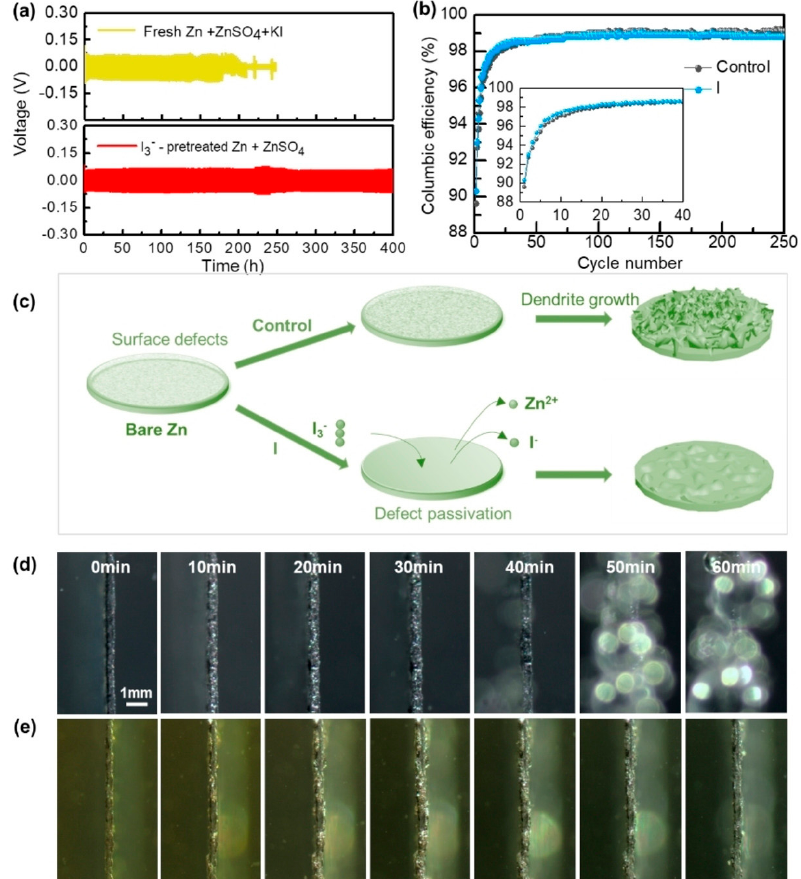
Figure 8. ( a ) The voltage profiles of Zn/Zn symmetric cells with either fresh Zn in KI + ZnSO 4 electrolyte or I 3 − -pretreated Zn in ZnSO 4 electrolyte; ( b ) Coulombic efficiencies of Zn/Cu symmetric cells in either control- or I electrolyte at a current density of 0.25 mA cm − 2 . ( c ) Schematic illustration showing the effects of the I 3 − additive on Zn electrodes’ striping/plating process. Optical micro- graphs of Zn 2+ deposition behavior in: ( d ) control- and ( e ) I electrolyte. Reproduced with permissions from Ref. [69]. Copyright © 2022